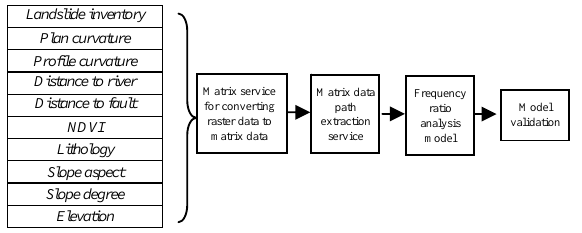
Figure 2. Building the training service